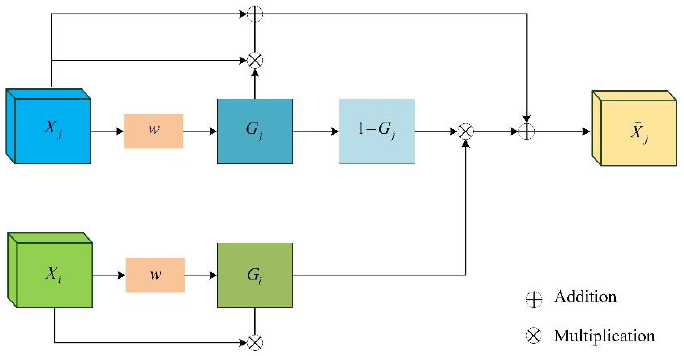
Figure 3. The structure of gated fusion model.